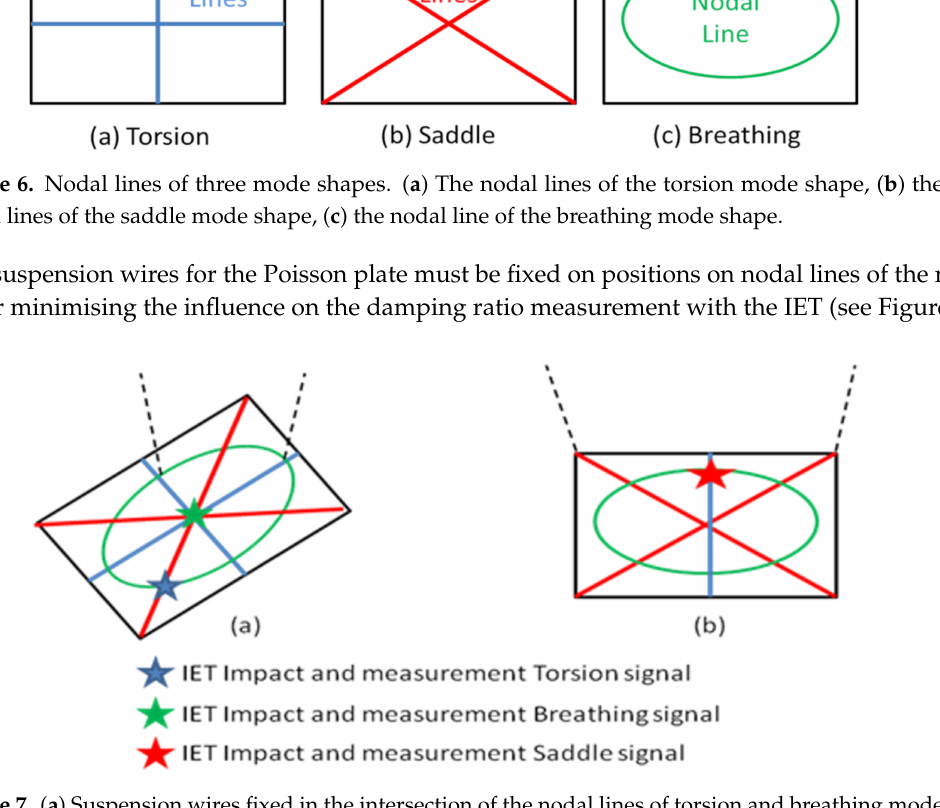
Figure 7. ( a ) Suspension wires fixed in the intersection of the nodal lines of torsion and breathing mode shapes, ( b ) suspension wires fixed in the corners of the Poisson